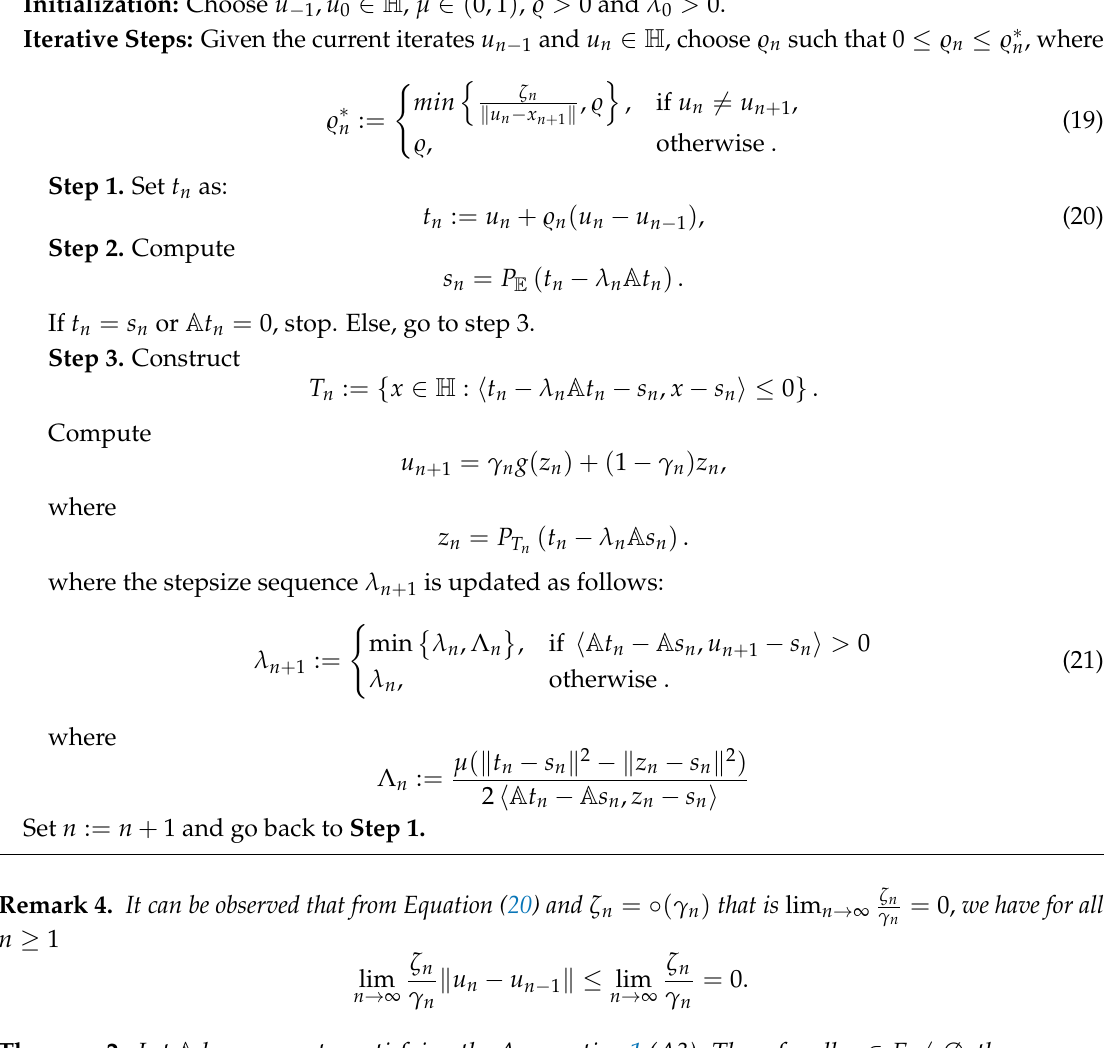
Algorithm 2 Adaptive Subgradient Extragradient Algorithm for Pseudomonotone